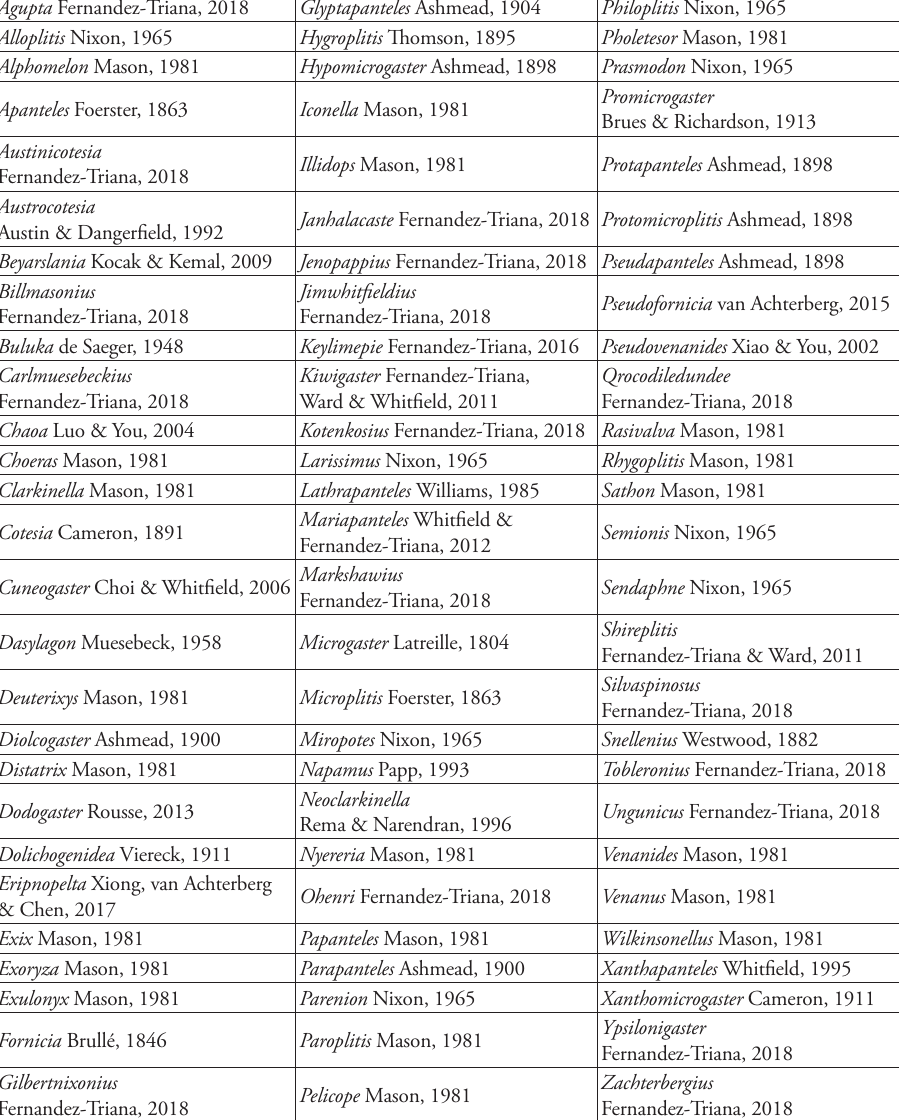
Table 2. Updated list of 81 extant genera of Microgastrinae worldwide. Based on Whitfield et al. (2018), with the addition of Xiong et al. (2017) and the new genera described in the present